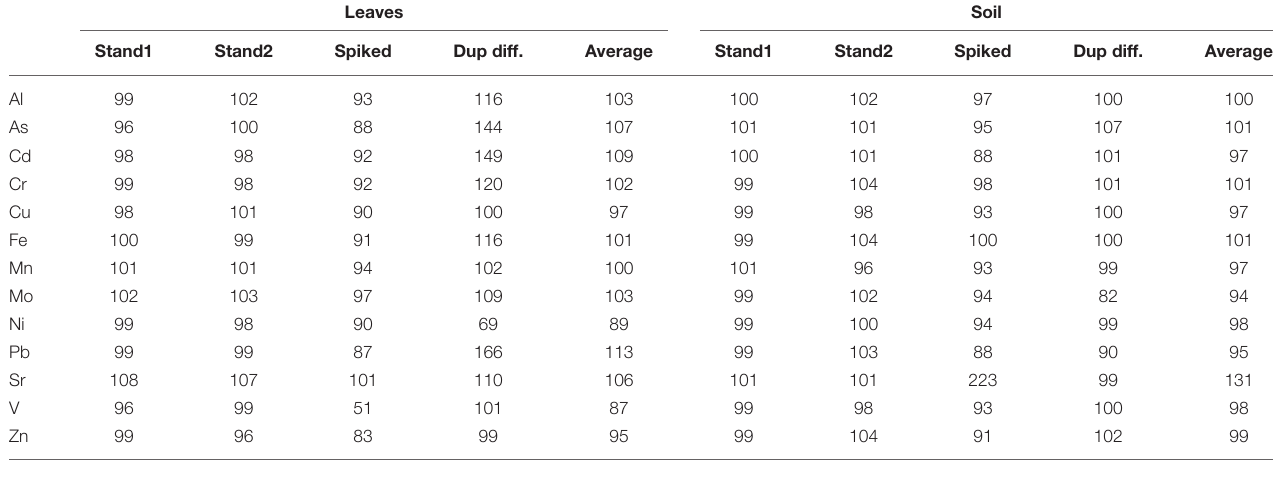
TABLE 2 | Average of % recovery of heavy metals in Avicennia marina leaves and soil. Leaves Soil